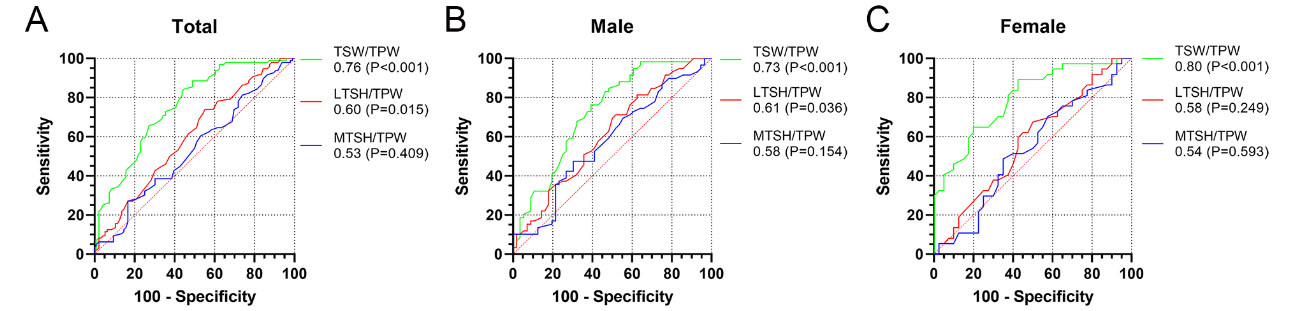
Figure 2. Differences in tibial spine morphologies between male and female subgroups. ( A , B ) show the results in males between the study group and control group. ( C , D ) show the results in females between the study group and control group. TSW, tibial spine width; LTSH, lateral tibial spine height; MTSH, medial tibial spine height; TPW, tibial plateau width; **, statistically significant with a p value of <0.001; n.s., not statistically significant.